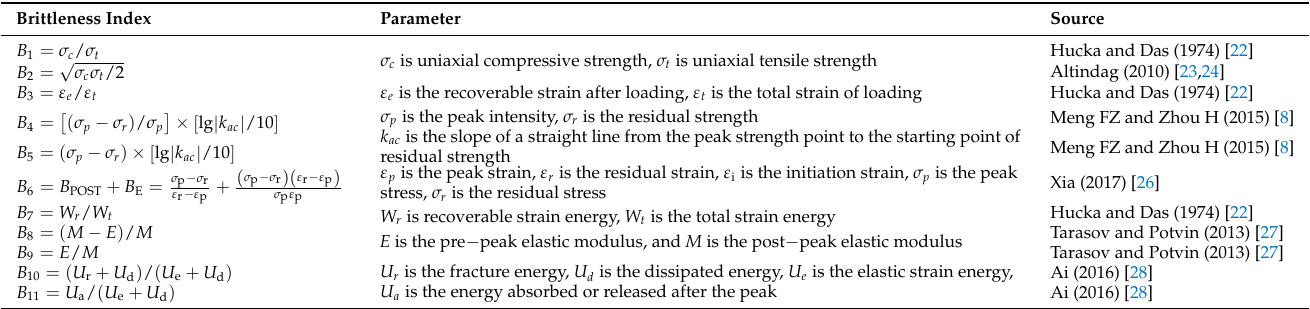
Table 1. List of common brittleness